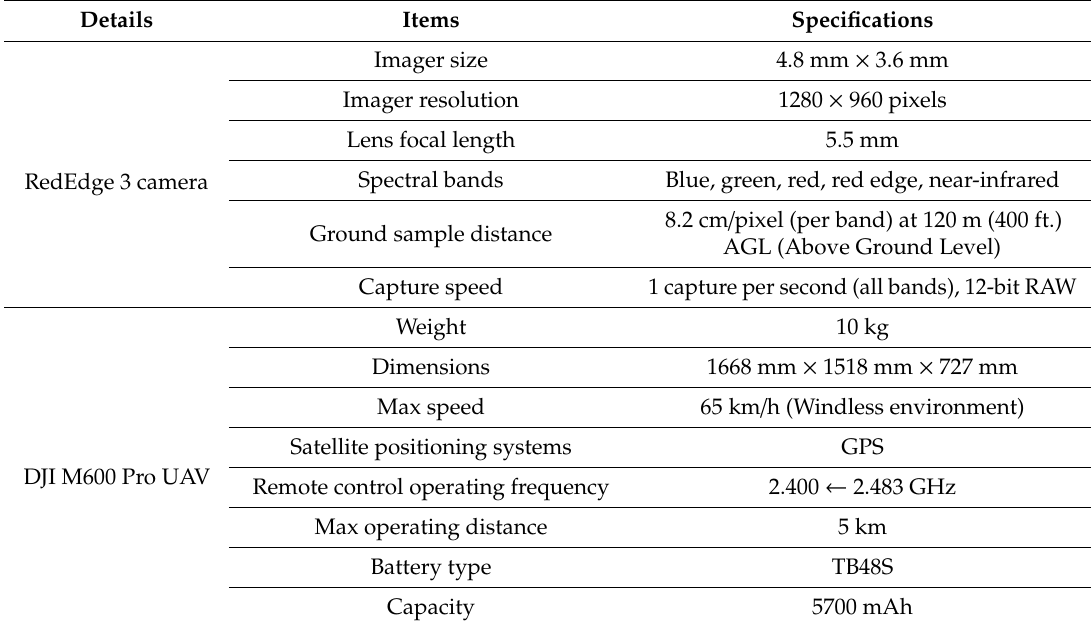
Table 1. Technical specifications of unmanned aerial vehicle (UAV) and multispectral